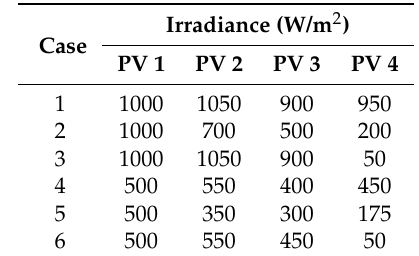
Table 2. Irradiance